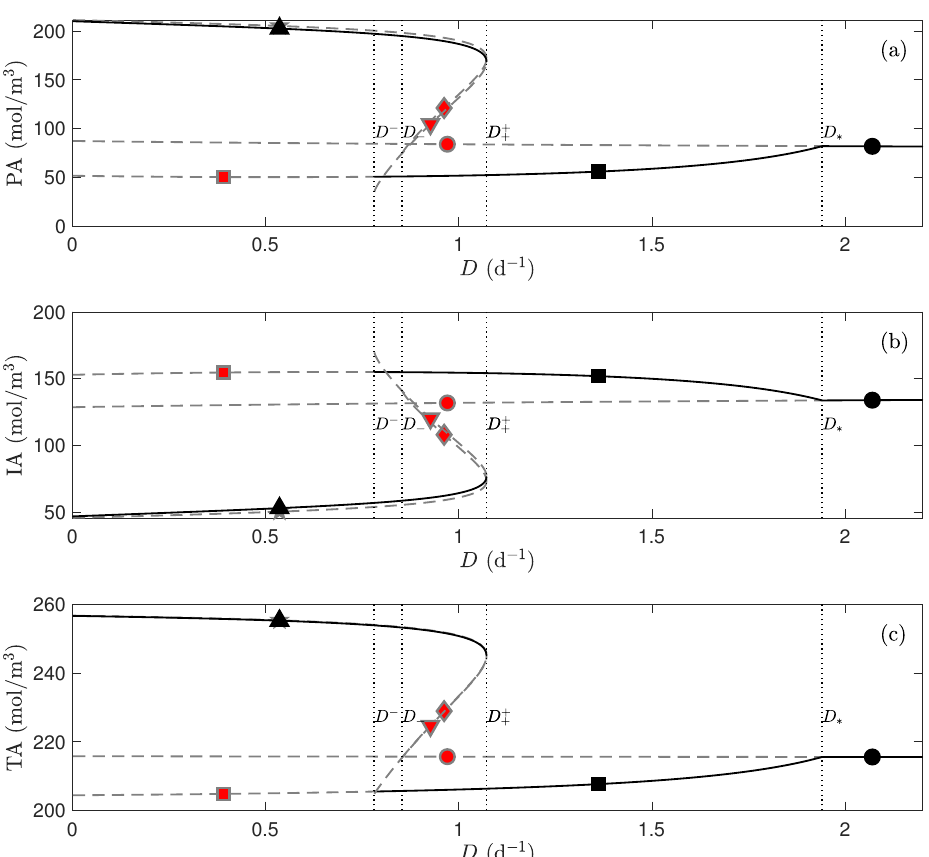
Figure 3. Bifurcation and stability analysis for alkalinities of the modified AM2 model with the parameters in Table 2. ( a ) Intermediate alkalinity, ( b ) partial alkalinity, and ( c ) total alkalinity. The continuous lines with black markers represent stable EP, the dashed lines with red markers represent unstable EP, and the dotted lines are the bifurcation points, while the shape of markers indicates the regions for each EP: = EP1, (cid:4) = EP2, (cid:7) = EP3a, (cid:70) = EP3b, (cid:72) = EP4a, and (cid:78) = (cid:32)